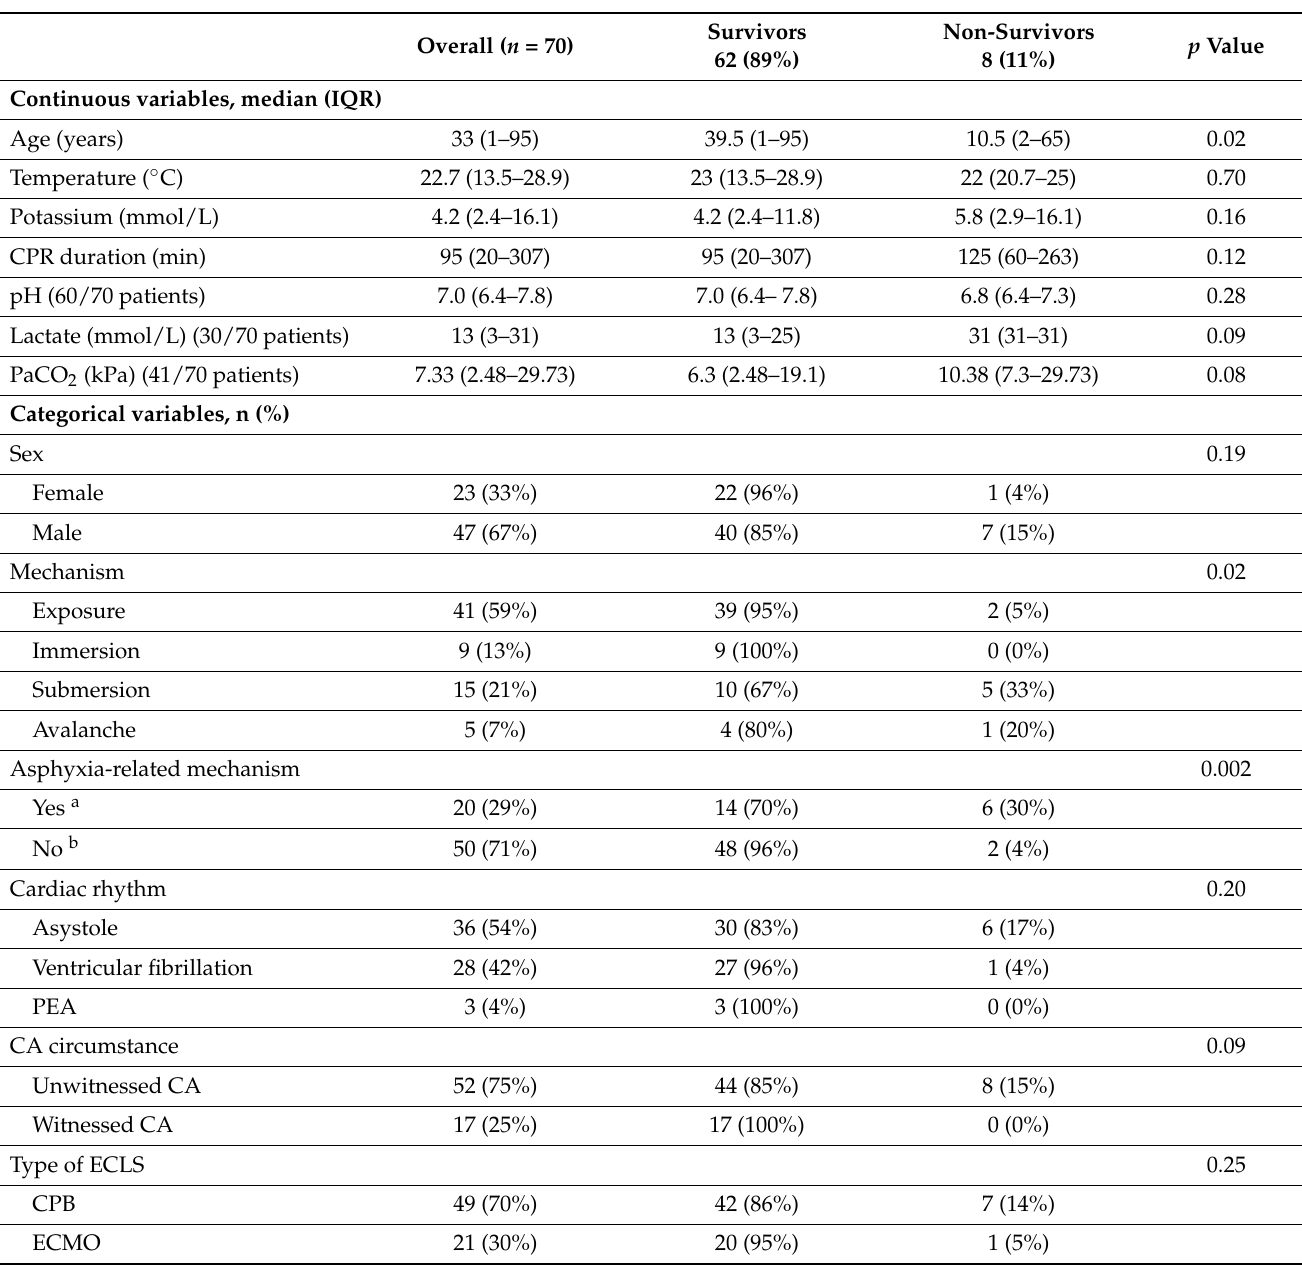
Table 1. Patient characteristics and outcomes ( n = 70).